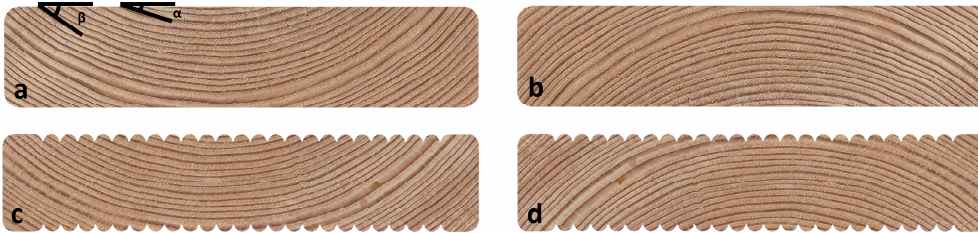
Figure 1. Orientation of growth rings to the upper exposed surface of flat-sawn (tangential) western larch deckboards. The darker bands within growth rings are latewood and the lighter bands are earlywood: ( a ) flat board with growth rings that curve towards the exposed upper surface. These are known as pith-side-up boards. Growth rings can make shallow ( α ) or high ( β ) angles to the exposed upper surface; ( b ) flat board with growth rings that curve away from the exposed upper surface. These are known as bark-side-up boards; ( c ) profiled pith-side-up board; and, ( d ) profiled bark-side-up